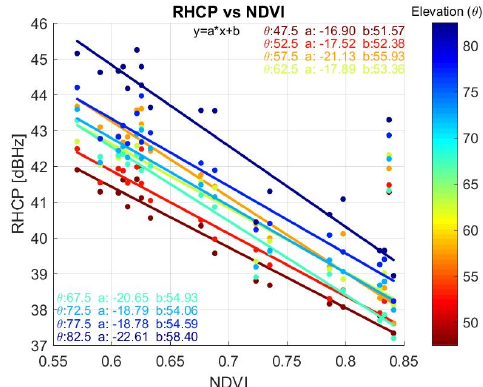
Figure 13. Dependence of the RHCP C/N 0 and the NDVI for different satellite elevation angles, and linear fits.